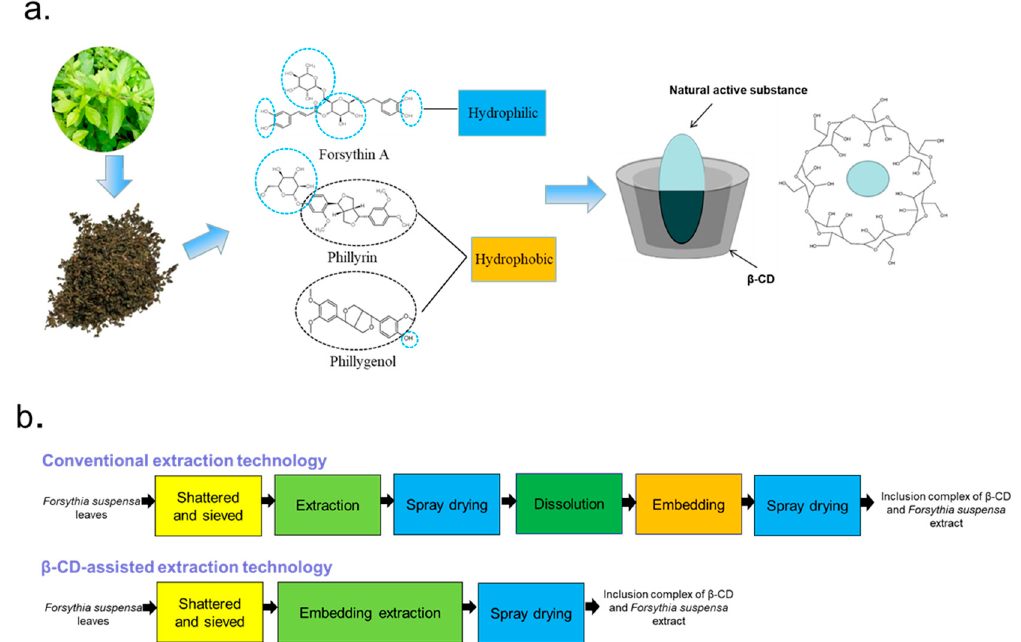
Figure 1. β -cyclodextrin ( β -CD)-assisted extraction principle. Natural active molecules’ interaction with β -CD ( a ) and schematic of β -CD-assisted extraction ( b ).